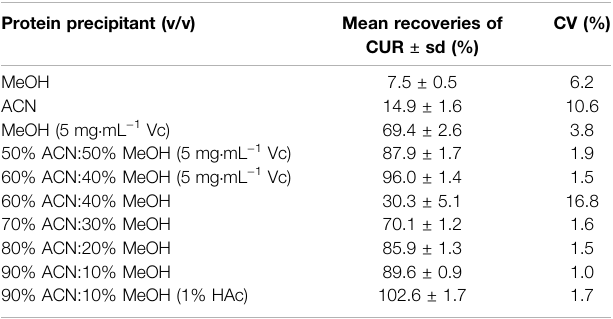
TABLE 2 | Calibration curves of compounds in plasma and